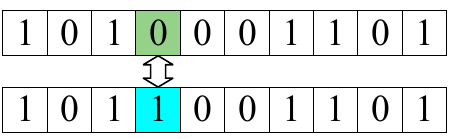
Figure 5. Schematic diagram of 0–1 single mutation.